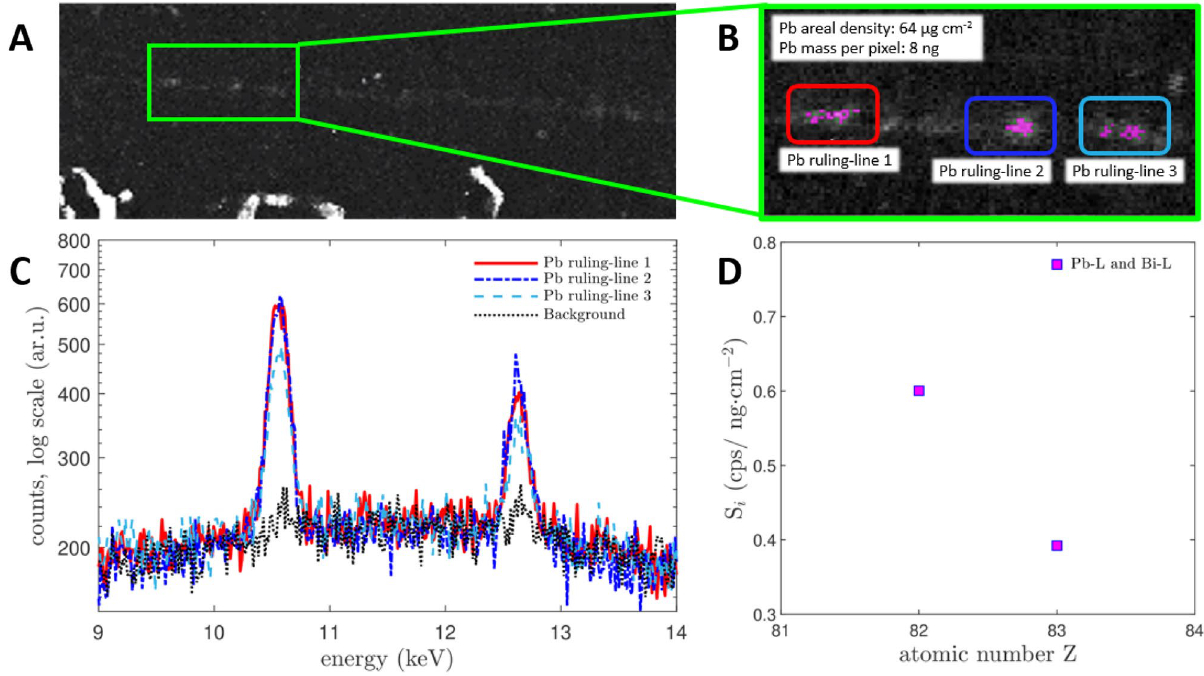
Figure 5. Lead estimation procedure. Pb-Lα map of PHerc . 1018, ‘cornice’ 1 taken for this sample at a scanning step size of 100 μm and dwell time of 50 ms ( A ), zoomed area, showing the sampled selection, purple pixels, within the labelled color-coded regions ( B ), Pb-L signal in the integrated spectra of the selected pixels along the ruling line and on the background obtained by randomly sampling pixels across the papyrus rolls, outside of the ruling lines, in logarithmic scale ( C ) and Sensitivity (S i ) of the MA-XRF scanner in the energy region of the Pb-L lines ( D